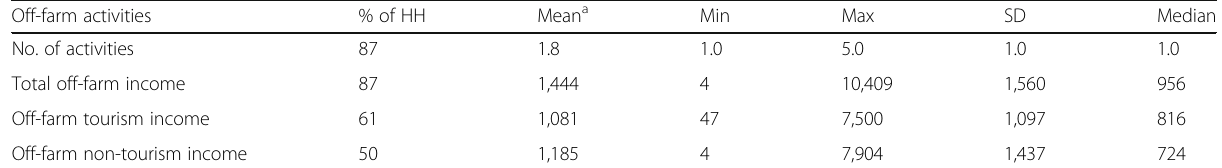
Table 5 Households involved in off-farm activities and household annual income (US$) from off-farm tourism and non-tourism